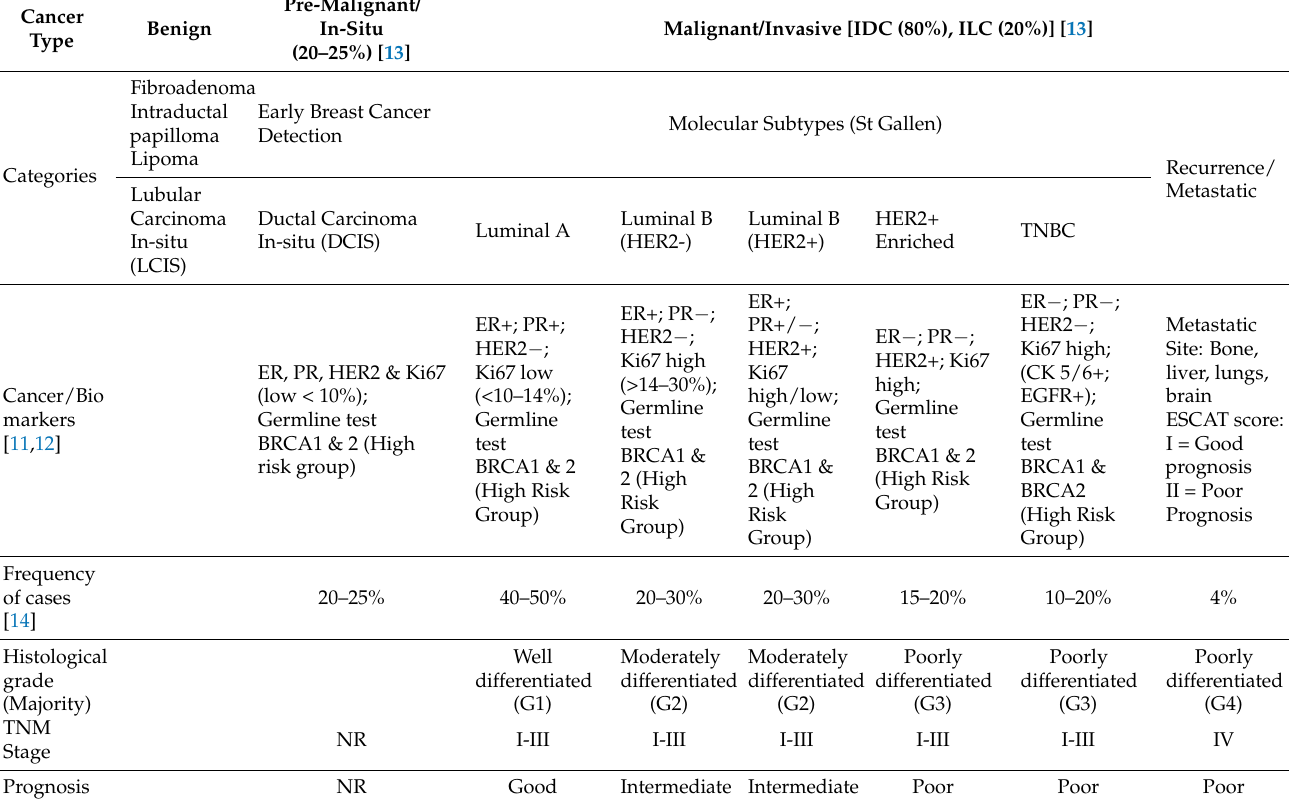
Table 1. Clinical and molecular classification of